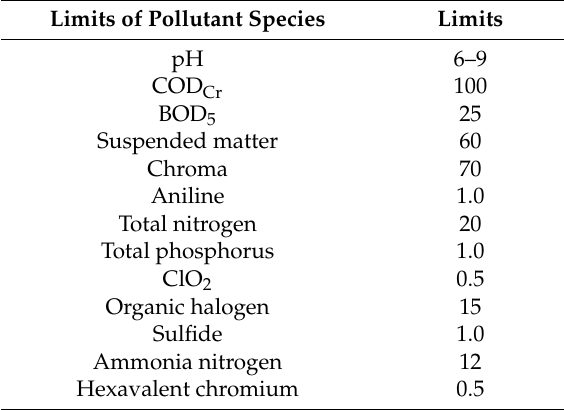
Table 3. Emission limits for waste water pollutants in the textile industry. Unit: mg/L.